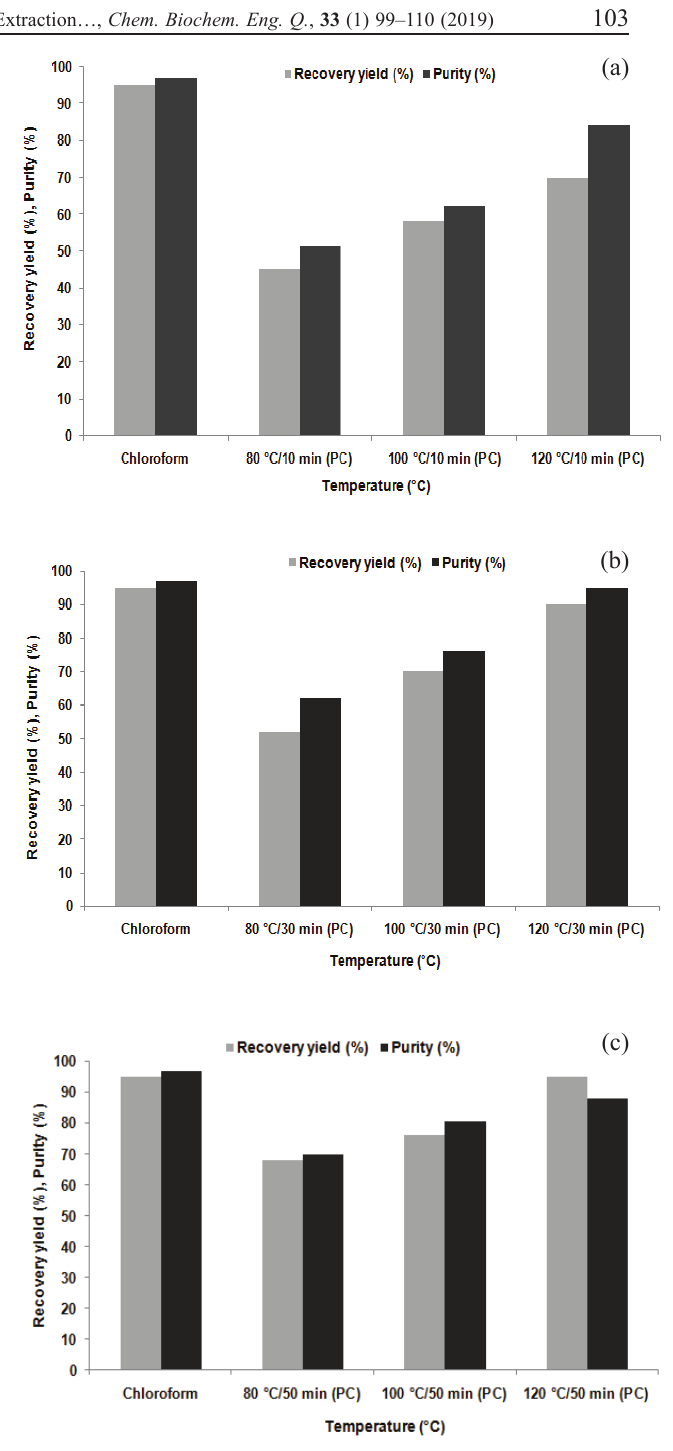
Fig. 1 – Effect of different temperatures on purity and recov- ery yield (%) of PHAs obtained by extraction with chloroform and 1,2-propylene carbonate (1,2-PC) at a) 10 min incubation period; b) 30 min incubation period; c) 50 min incubation